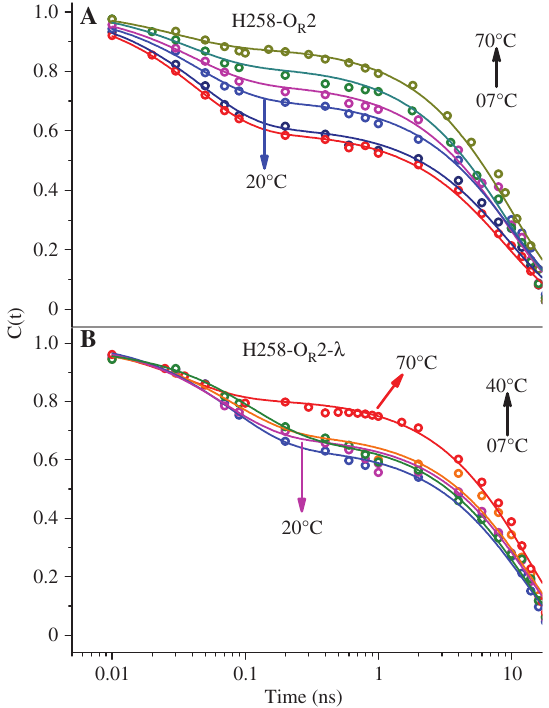
Figure 18 Temporal decay of the solvation correlation function [C(t)] at different temperatures for the H258 in (A) O repressor complex. The time has been plotted on a logarithmic scale. Solid lines indi- cate exponential fitting of the experimental data points. [Reprinted with permission from ref. (31) Copyright 2013, Elsevier